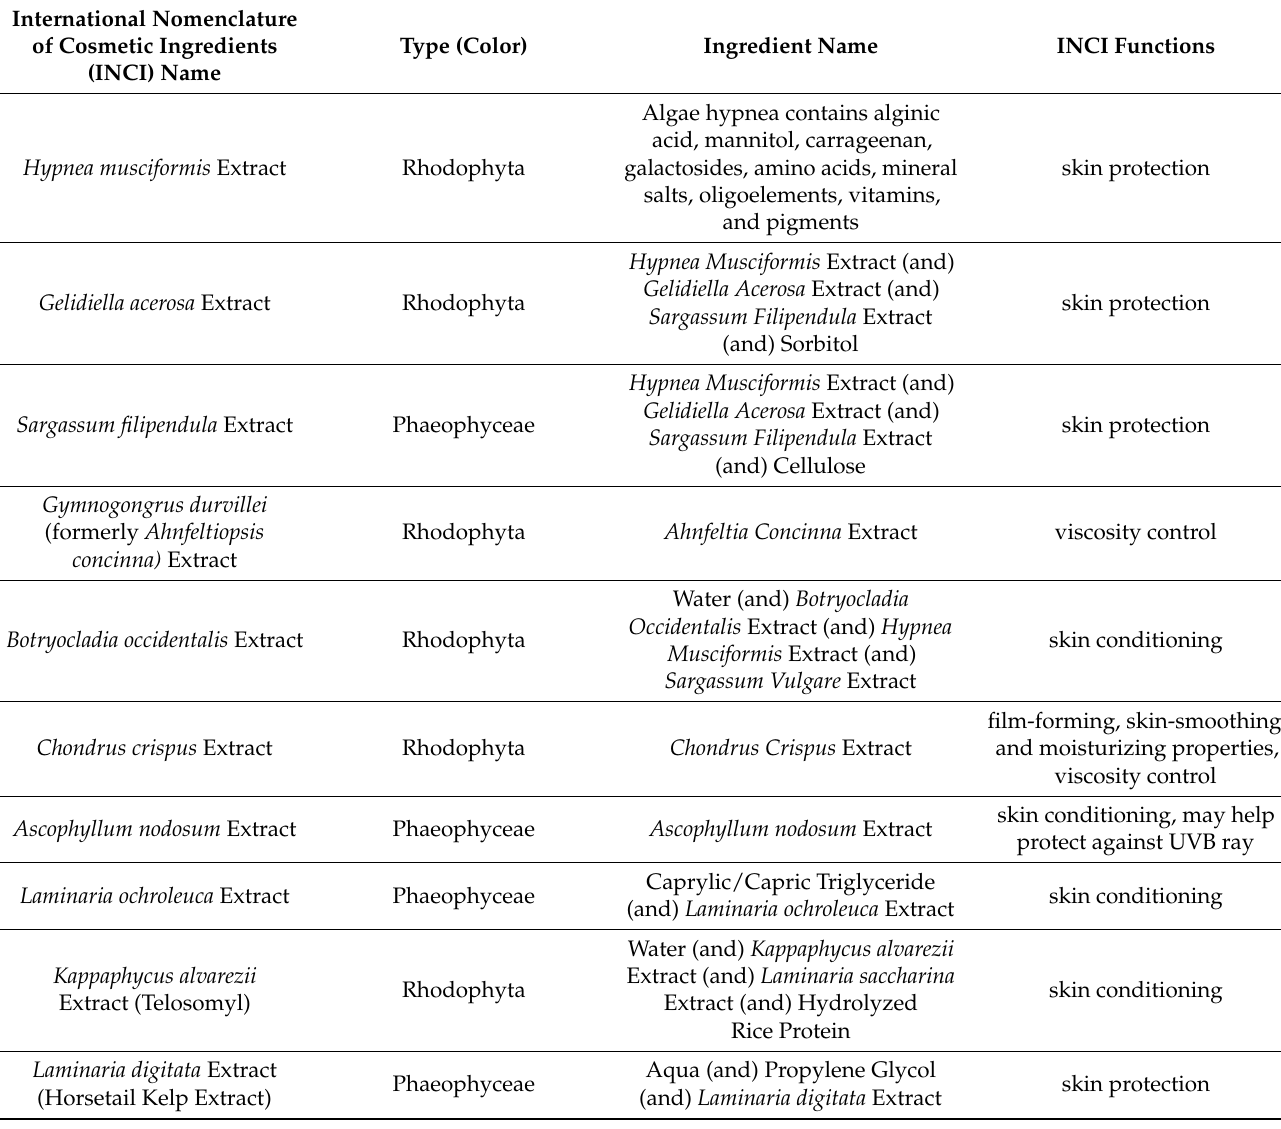
Table 2. Examples of macroalgae extracts used as ingredients by the cosmetic